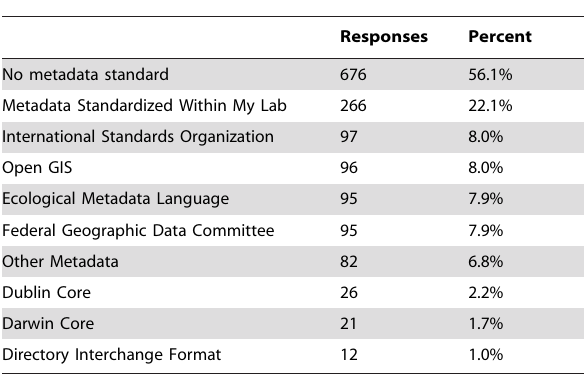
Table 9. Metadata standards.